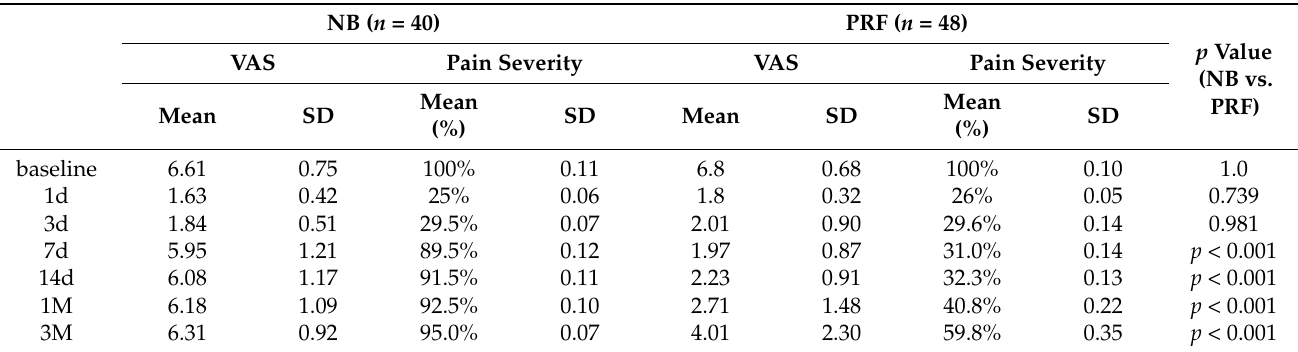
Table 3. Changes in VAS and pain severity between the NB and PRF groups. NB = nerve block,